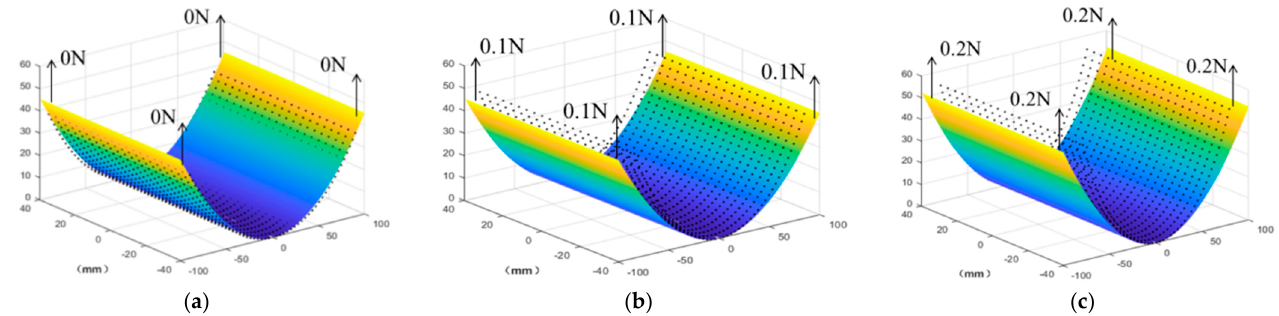
Figure 4. Predicted stable configurations of bistable laminates under different applied force, curved surface–theoretical results, discrete points–FEA. ( a ) 0 N; ( b ) 0.1 N; ( c ) 0.2 N.